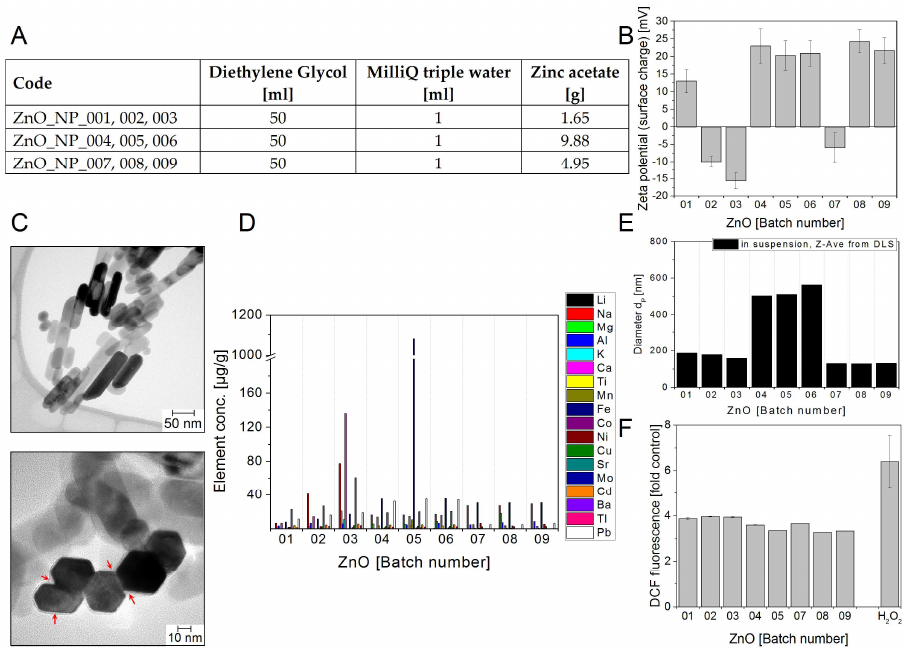
Figure 3. Zinc oxide NM batches ZnO NP01–09 ( A ) Production parameters for the different zinc oxide nanoparticles. ( B ) Zeta potential representing the surface charge in mV at pH ~ 6. ( C ) Representative TEM images. Regions marked with arrows seem to be amorphous material in between and around agglomerated single-crystalline ZnO nanorods. ( D ) Selected impurities present in the different flame synthesized ZnO NM batches. The mass concentrations of elements above detection limit are shown. The data represent the mean of two assays. ( E ) Particle diameters d P in nm: Z-Average of d P determined in aqueous suspension using DLS. ( F ) Potential to induce ROS. The test NMs were delivered as suspensions of 5 mg/mL in water. The graph shows the DCF fluorescence induced by the different batches at 400 µg/mL relative to a sample without NMs (control). 0.3 µM H 2 O 2 was used as positive control. The data represent mean values of 2–6 replicates ± s.e.m obtained in one to two experiments.